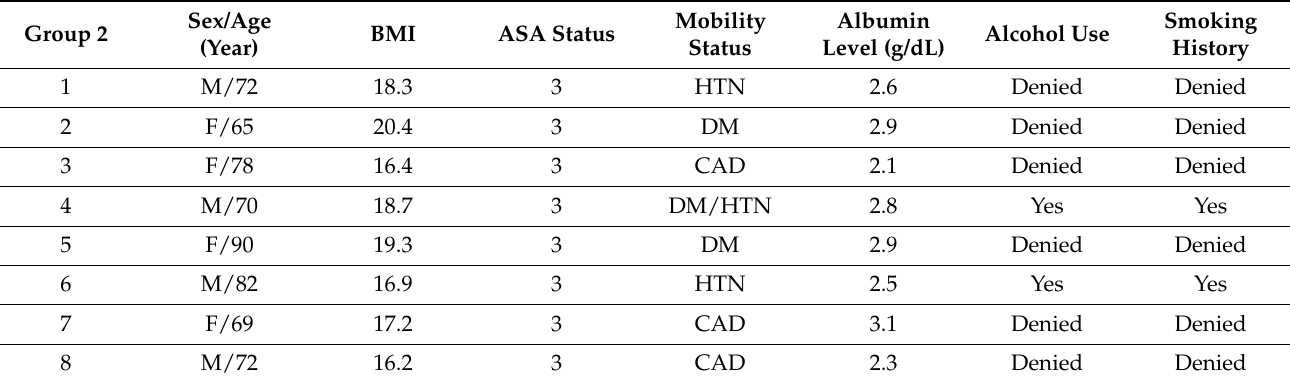
Table 2. Retrospective reviewed data from second 8